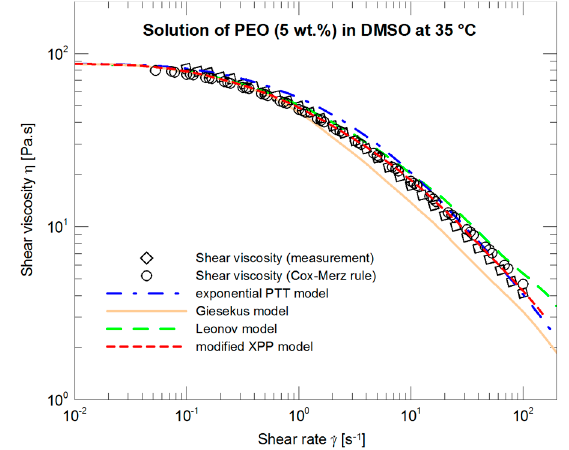
Figure 14. A description of steady shear viscosity by the exponential PTT, Giesekus, Leonov, and modified XPP models using the nonlinear parameters optimized with respect to the LAOS measurements (Figure 11).